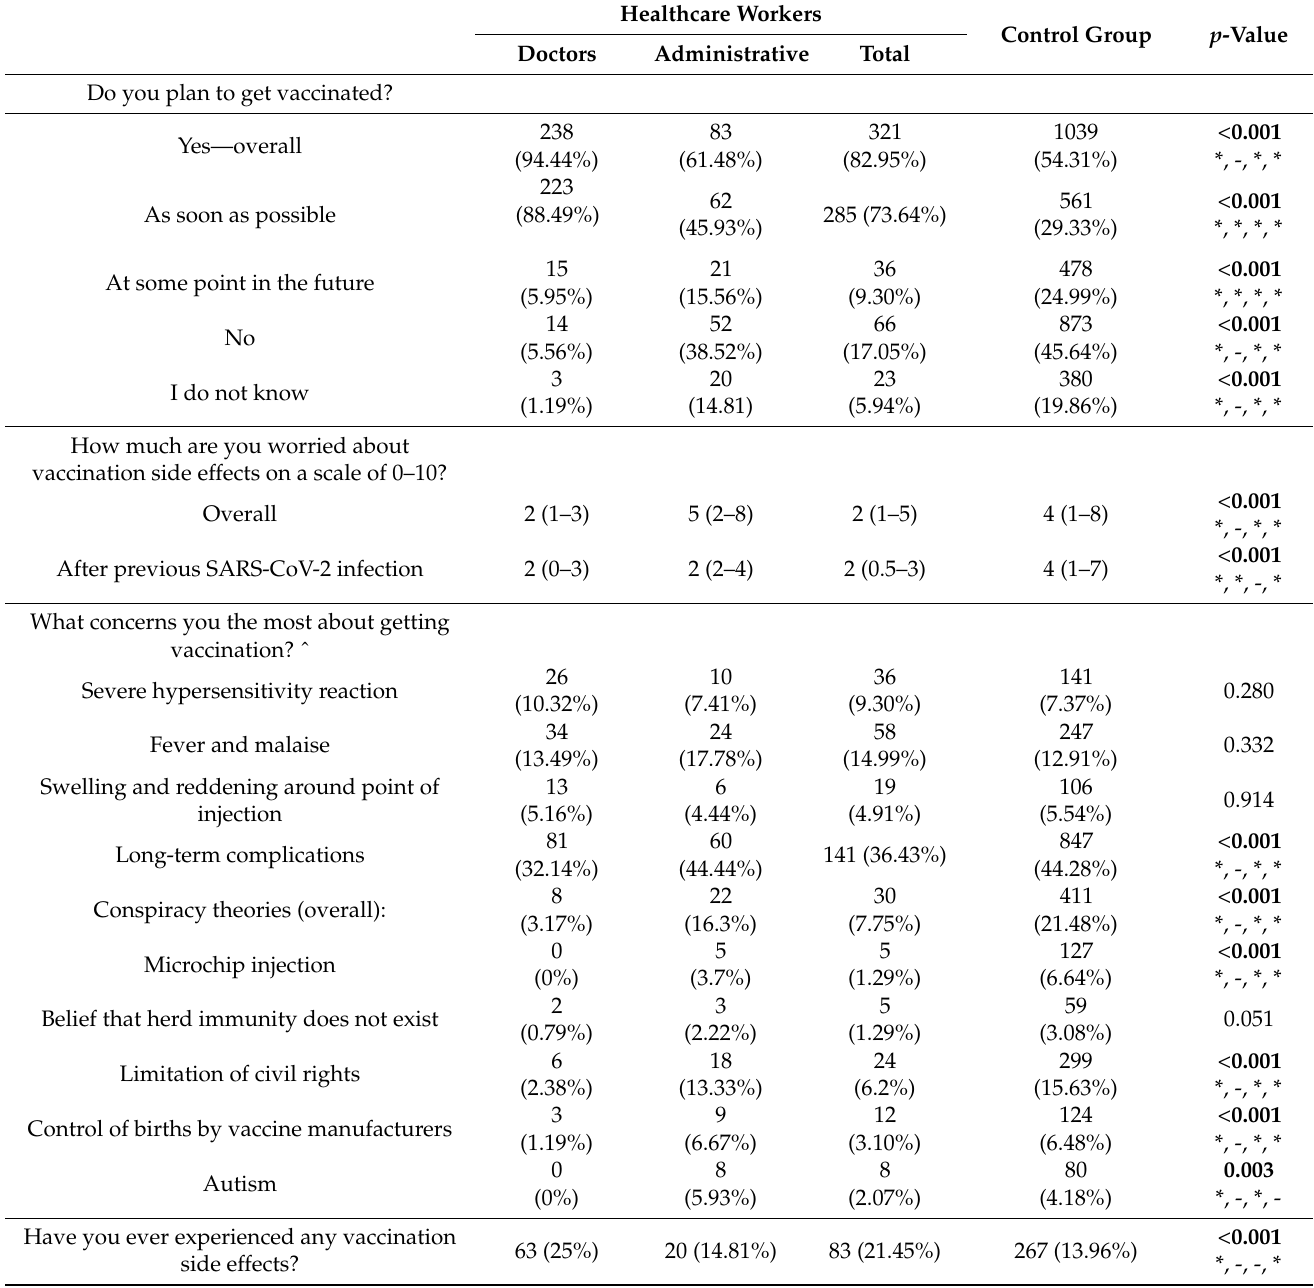
Healthcare Workers